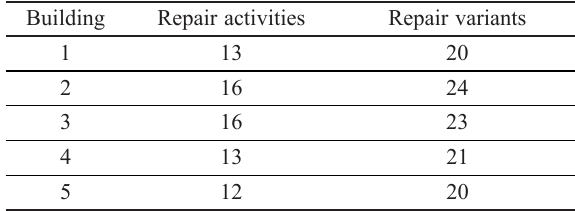
table 3. Proposed repair and variants for 5 buildings